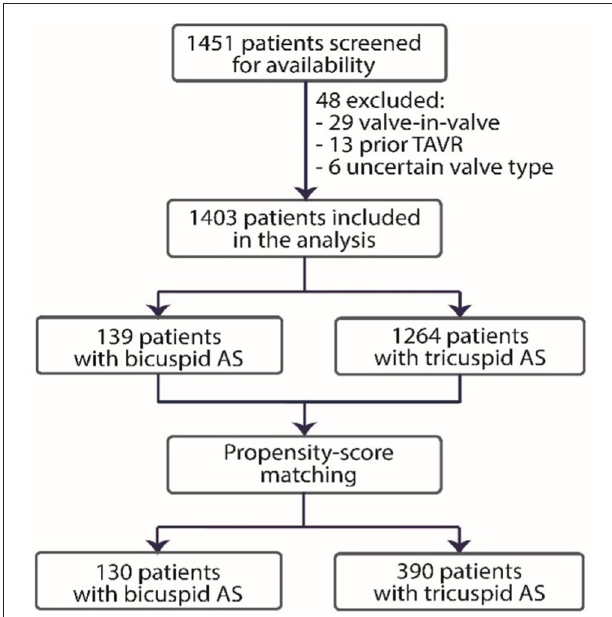
FIGURE 1 | Study flowchart. TAVR, transcatheter aortic valve replacement; AS, aortic